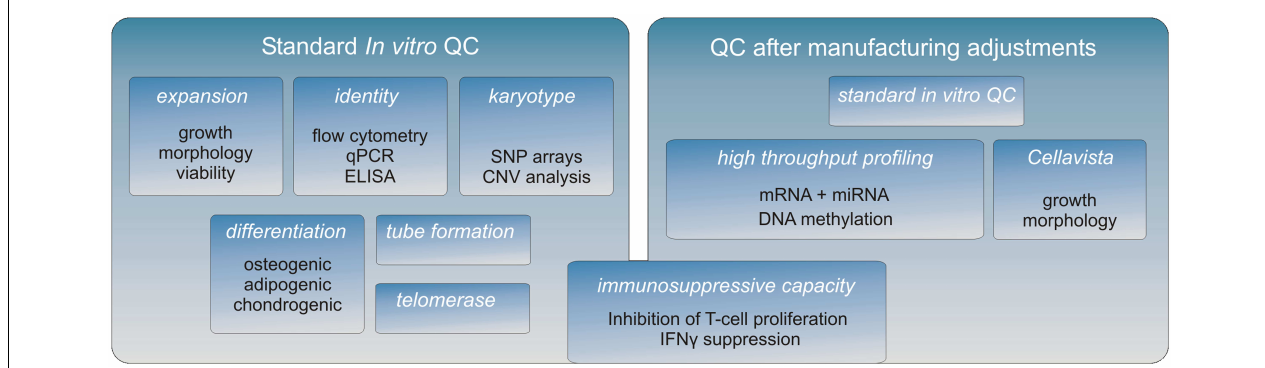
different platforms including array technology, PCR-based screening, and next-generation sequencing (NGS). Combining these “omics” data